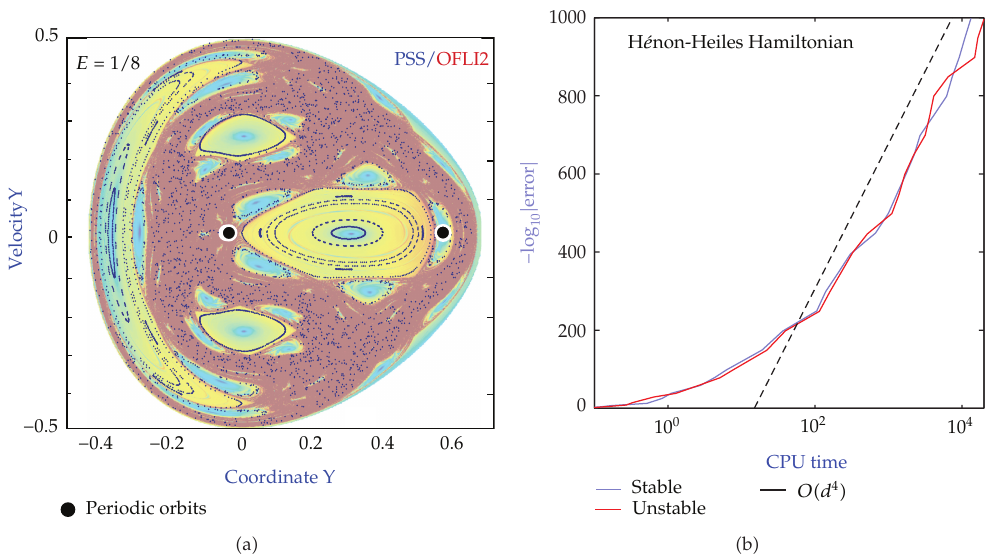
Figure 1: (cid:3) a (cid:4) : OFLI2 and PSS section of the H´enon-Heiles problem for x (cid:8) 0 and Energy E (cid:8) 1 / 8. (cid:3) b (cid:4) : Computational relative error versus CPU time for the correction method applied to the two marked periodic orbits on the left